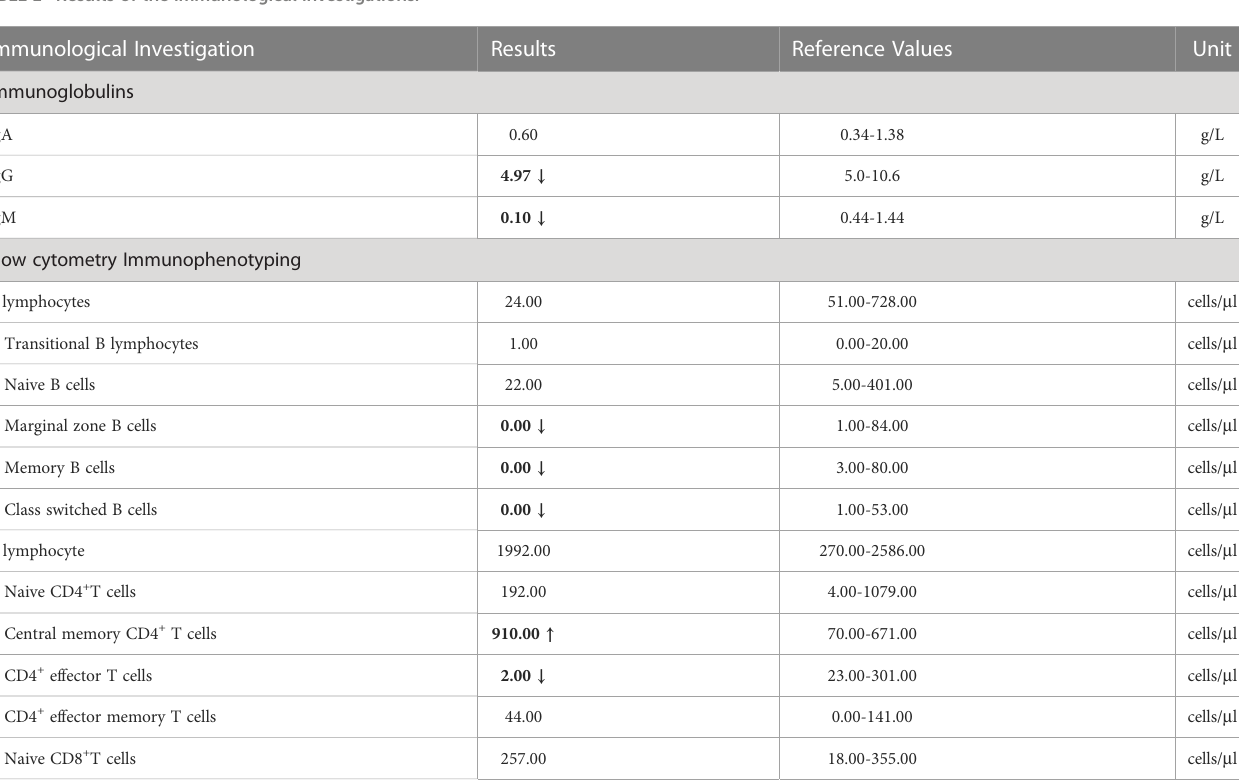
TABLE 1 Results of the immunological